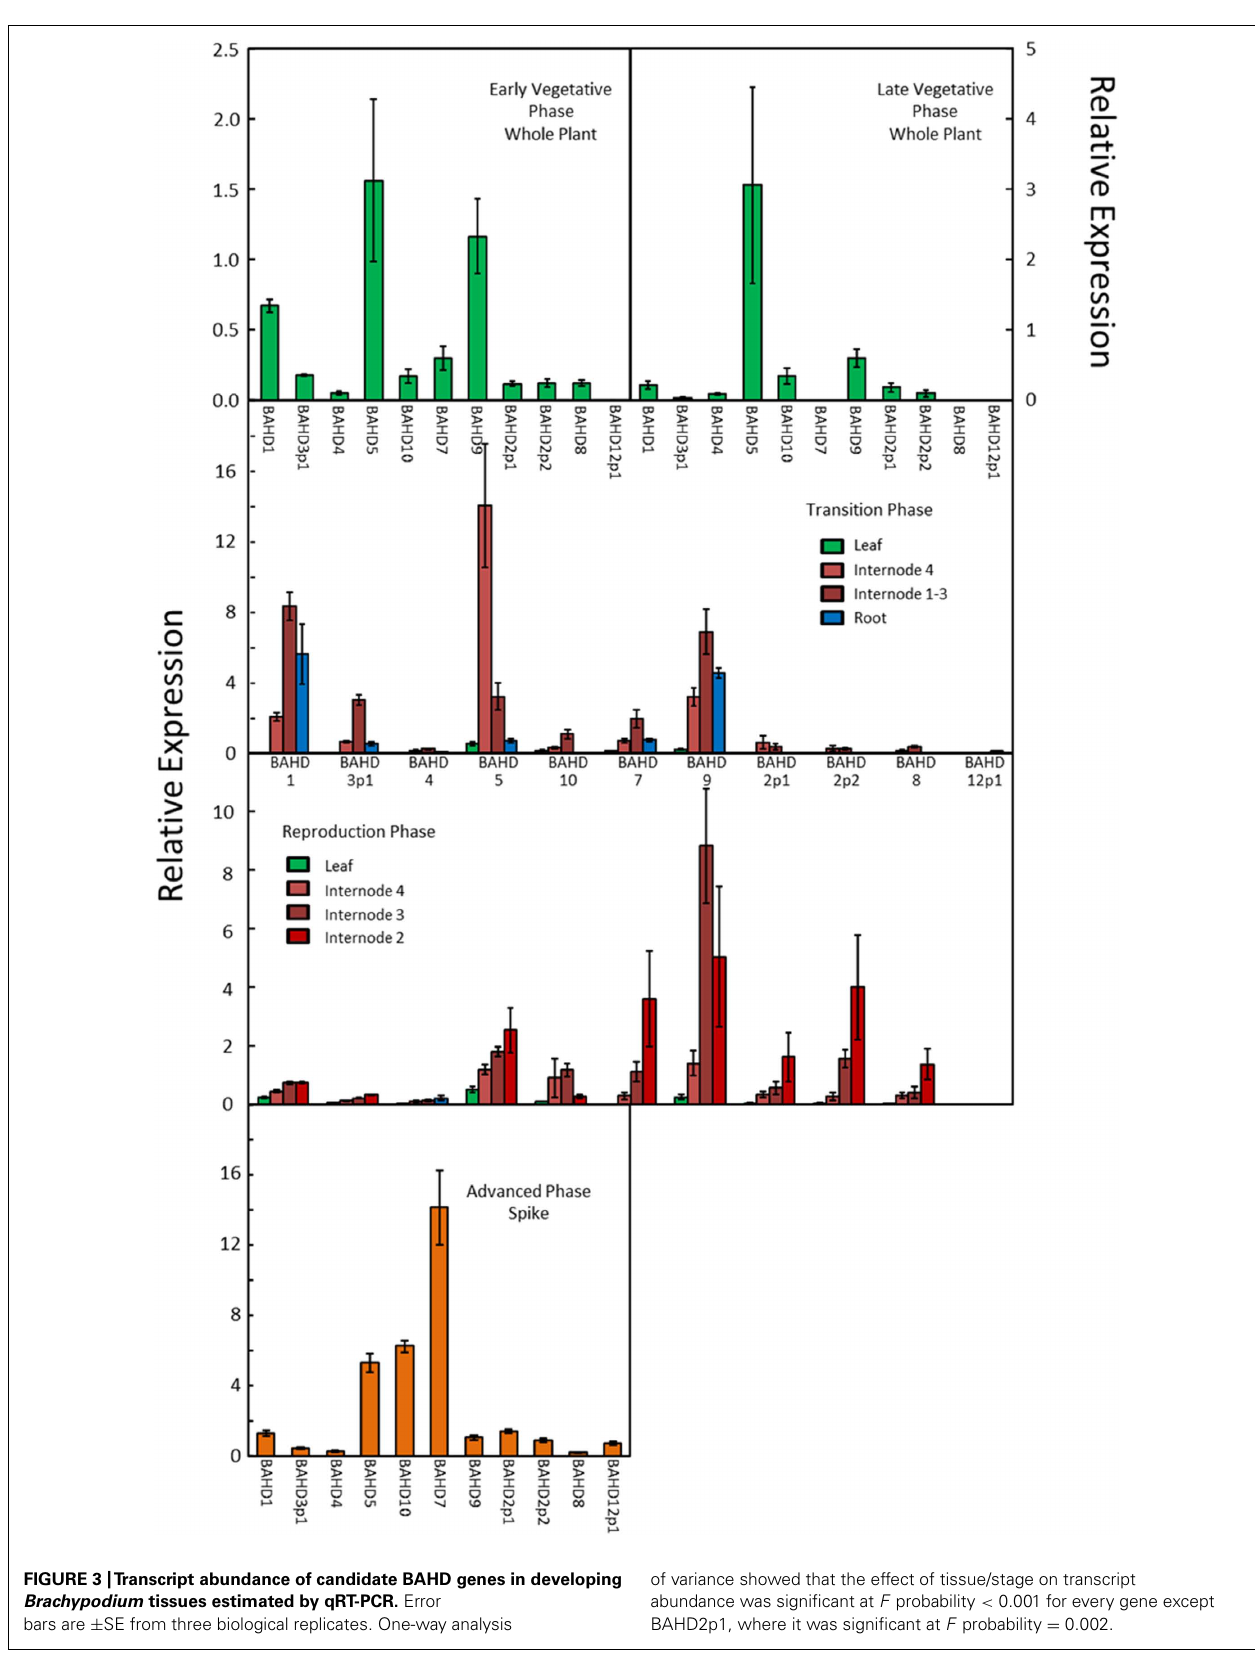
of variance showed that the effect of tissue/stage on transcript abundance was significant at F probability < 0.001 for every gene except BAHD2p1, where it was significant at F probability =